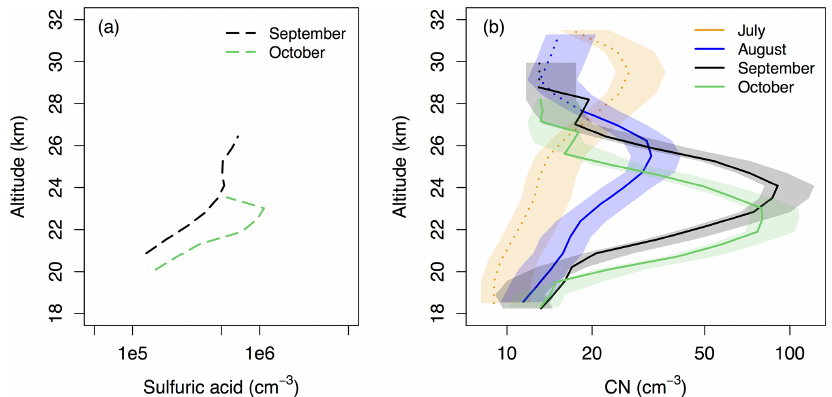
Figure 3. CN layer gaseous sulfuric acid profiles (a) and the simulated CN using these profiles (b) . We derive the sulfuric acid if the simulated CN concentrations in Fig. 2b are too low without gaseous sulfuric acid being present and therefore nucleation and condensational growth are needed to simulate the CN layer. As in Fig. 2b, the dotted lines are the initial CN based on observations and the solid lines are the simulated CN. The uncertainty ranges of the measured CN from Campbell and Deshler (2014) are shown as shaded areas for